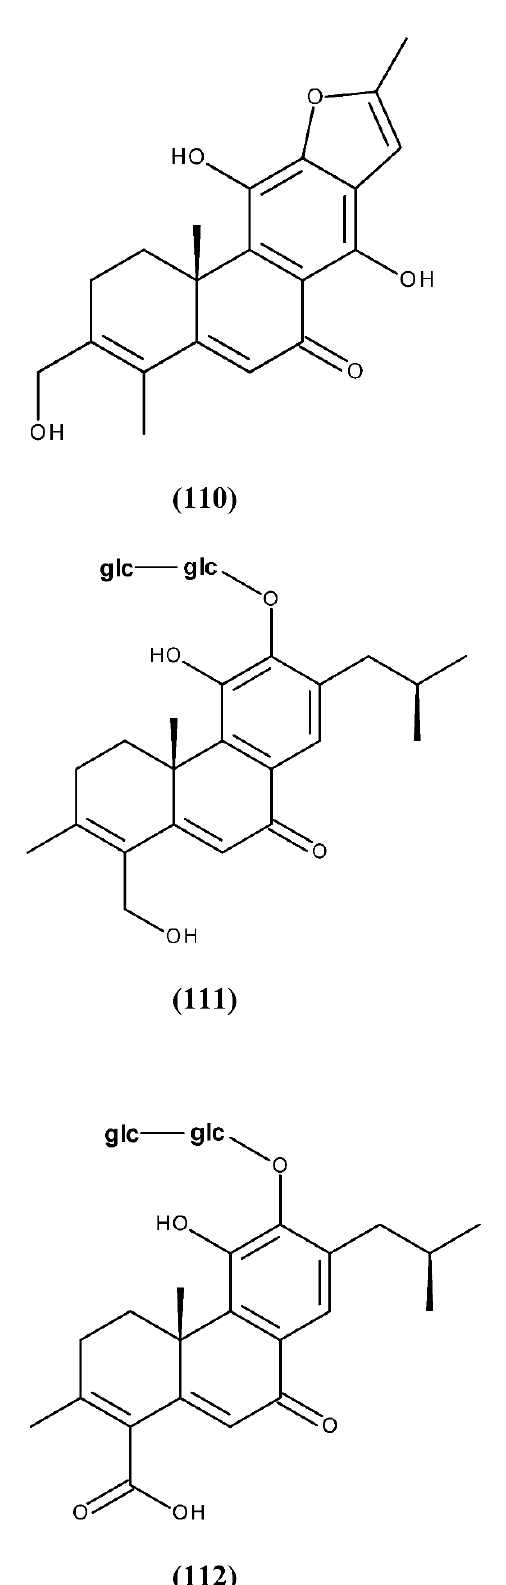
Figure 2. The chemical structure of the compounds isolated from Clerodendrum genus.